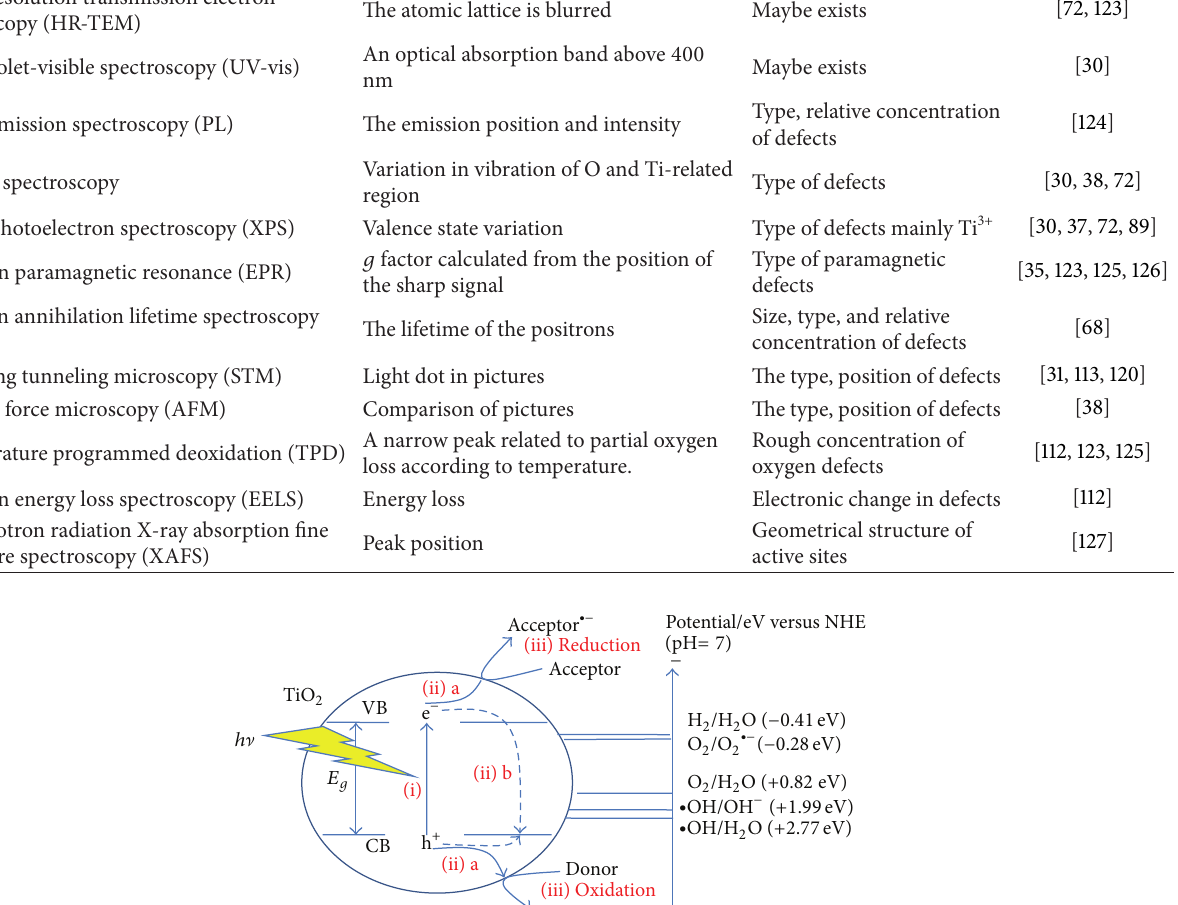
Figure1:Mainstepsoccurringinthephotoelectrochemicalmechanism.((i)Photonabsorptionandelectron-holepairgeneration.(ii)Charge separationandmigration(a)tosurfacereactionsitesor(b)torecombinationsites.(iii)Surfacechemicalreactionsatsurfaceactivesites,donor oxidation at valence-band hole, or acceptor reduction at electron